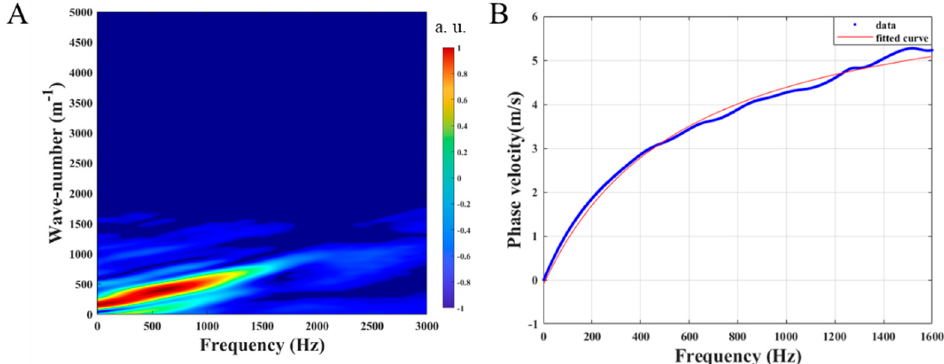
Figure 3. Phase velocity of the Lamb wave calculation, ( A ) is the wave-number frequency distribu- tion image of the spatial-temporal displacement, and ( B ) is the phase velocity dispersion curve with frequency.